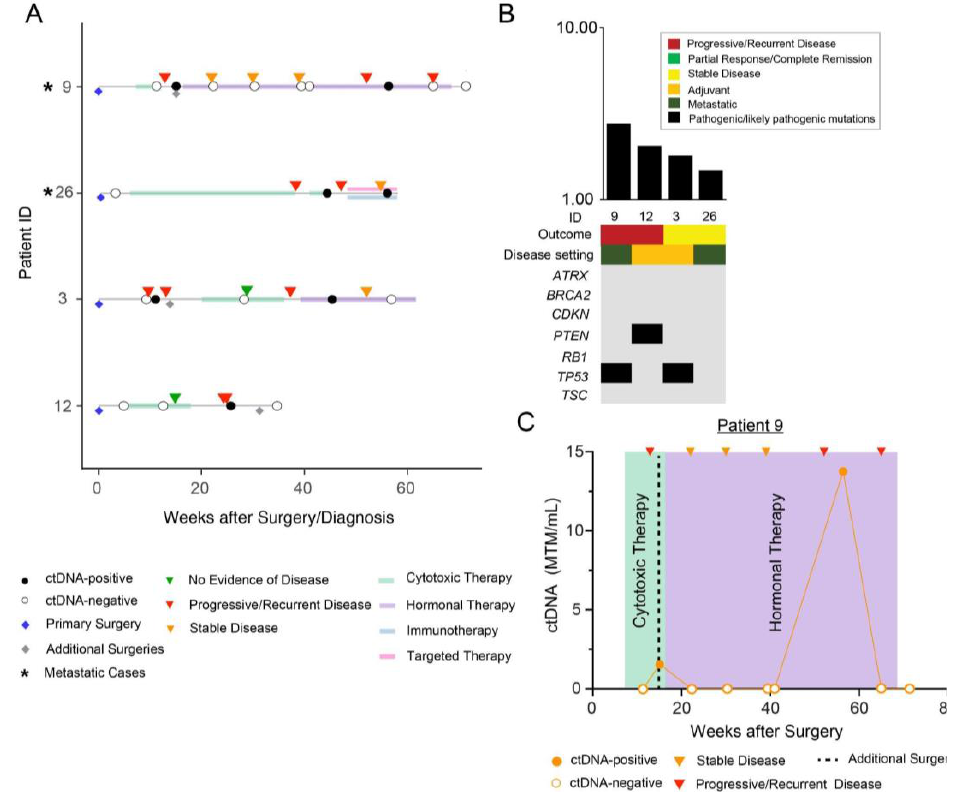
Figure 2. ( A ) Overview plot depicting the complete clinical course of all patients within sub-cohort B (initially ctDNA-negative but later became positive), including results of longitudinal ctDNA analysis. Patients with metastatic disease are marked with an asterisk “*” symbol. Blue diamond reflects initial/primary surgery performed to build the personalized ctDNA assay, all other additional surgeries are represented with grey diamonds. ( B ) Distribution of pathogenic and likely pathogenic driver mutations across the 4 patients in sub-cohort B. ( C ) Clinical course for patient #9 who underwent an initial TAH/BSO for an ER/PR+, grade 2 uLMS, followed by cytotoxic therapy, and several metastatic resections (not depicted). Tissue from her sixth debulking procedure (denoted as additional surgery) was used to develop a personalized ctDNA assay. She subsequently received additional chemotherapy and RT (not shown) and hormonal therapy (noted in